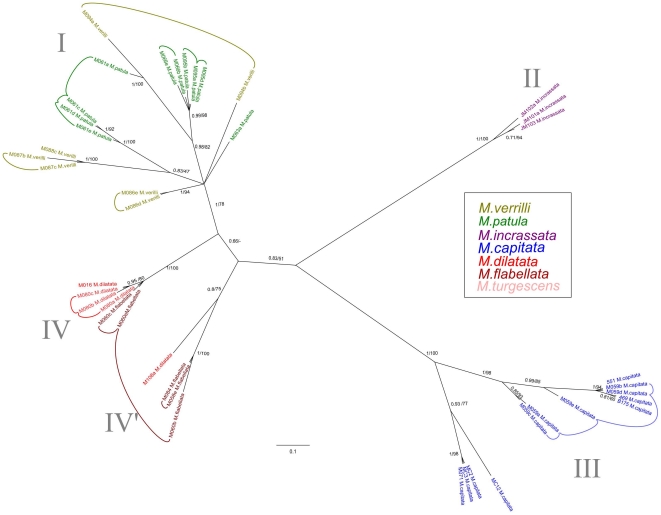
Cloned ITS region sequences for Hawaiian Montipora.Confidence values are BI/ML, and species are color coded by morphospecies identification. Colored lines indicate multiple sequences that were cloned from the same individual colony.